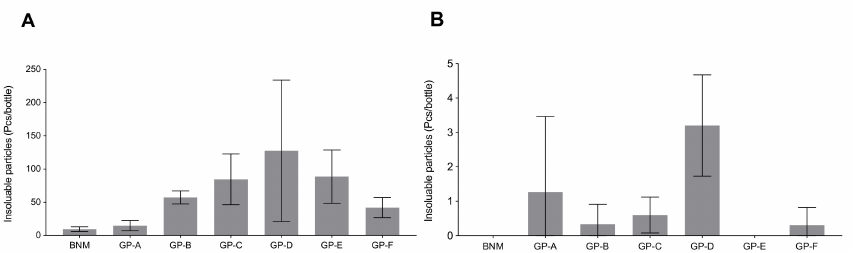
Figure 4. Number of insoluble particles detected in three batches of BNM and GPs ( A ): particle diameter greater than 10 µ m, ( B ): particle diameter greater than 25 µ m (N = 3 batches).